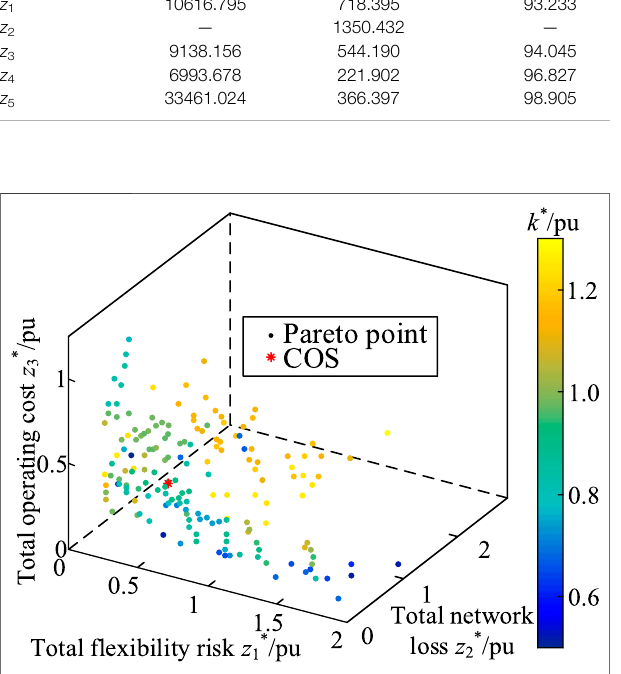
FIGURE 6 | Pareto frontier obtained by the grid-based ε -constraint method.